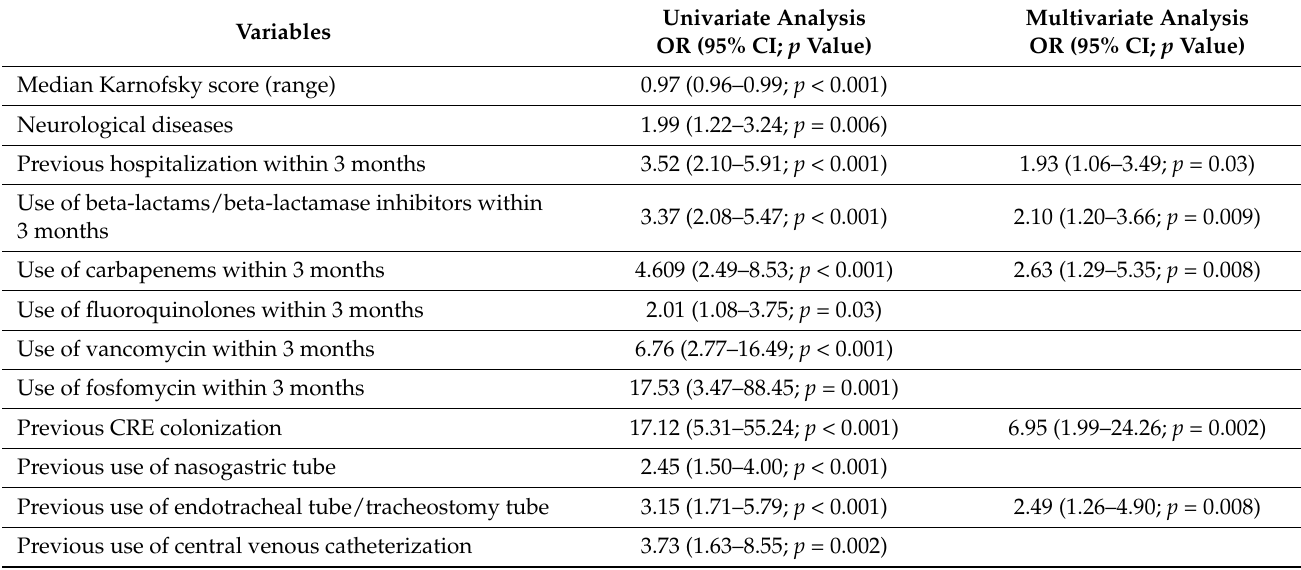
Table 2. Multivariate analyses of factors associated with CRE colonization on admission to